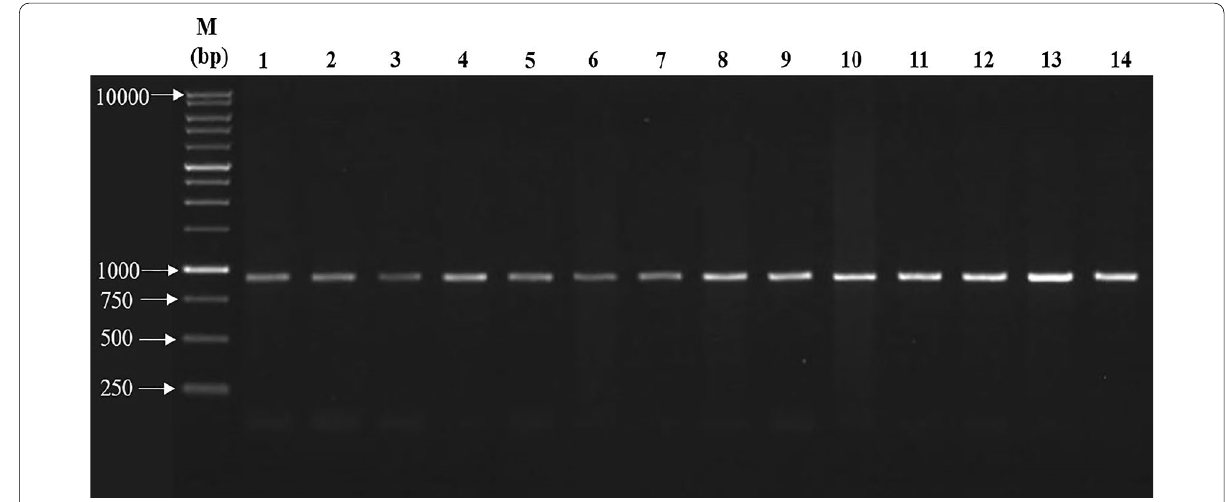
Fig. 2 Electropherogram amplicon of mat K gene of 14 banana cultivars. M Mas, Berlin, Kojo Santen, Ambon Hong, Morosebo, Raja Seribu, Triolin, Brentel Warangan, Saba Awu, Ebung, Raja Bandung, Kluthuk Ijo, Kluthuk Wulung